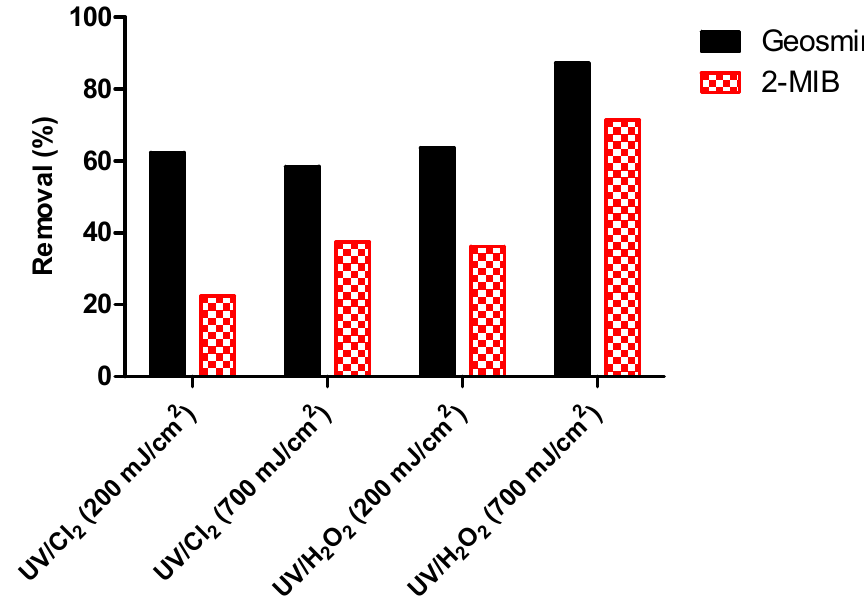
Figure 7. Trends in geosmin and 2-MIB removal by the UV/Cl 2 , and UV/H 2 O 2 processes at the lab-scale (initial geosmin concentration: 134.58 ng/L; initial 2-MIB concentration: 159.02 ng/L; UV dose: 0, 200, and 700 mJ/cm 2 ; Cl 2 dose: 5 mg/L; H 2 O 2 dose: 5 mg/L; initial pH: 6.9).